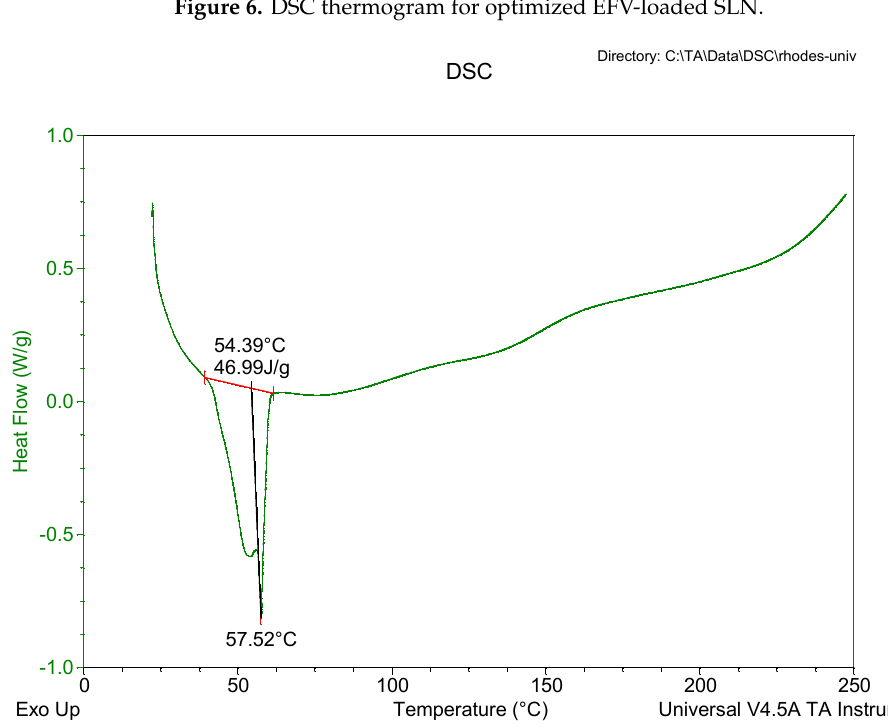
Figure 6. DSC thermogram for optimized EFV-loaded SLN .